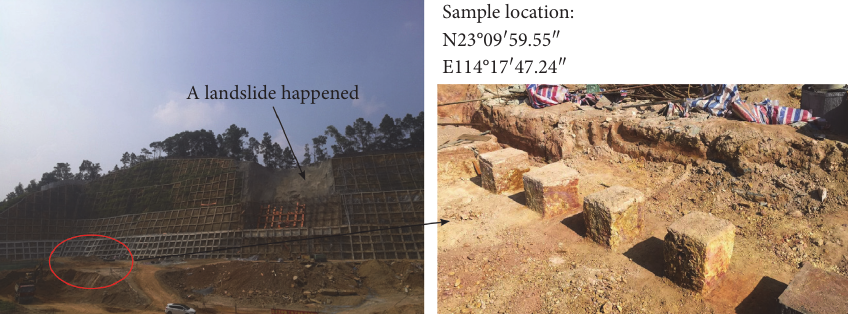
Figure 1: Sample location in Huizhou, China. Table 1: Material properties of the CDG soil.